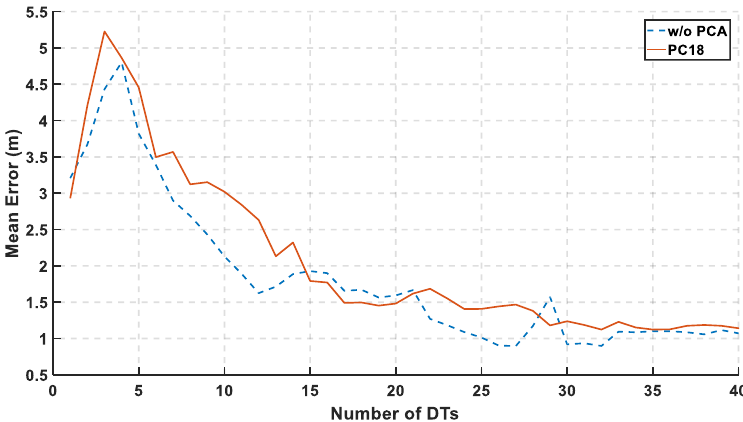
Figure 11. Mean Error Relative to the Number of Decision Trees (DTs) using 18th PCs.